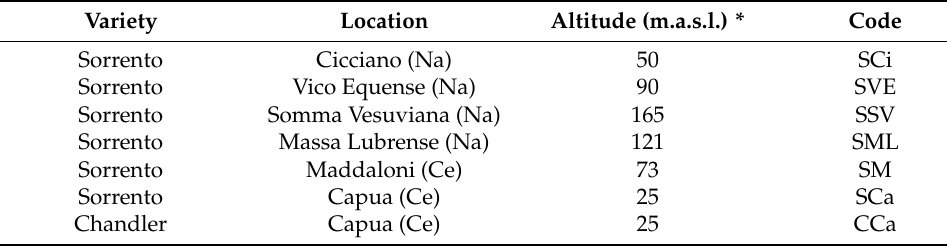
Table 1. Code of samples used for